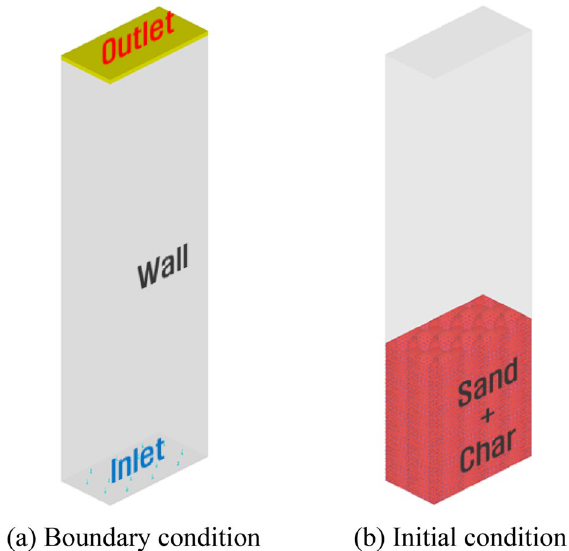
Figure 3. Boundary and initial conditions.